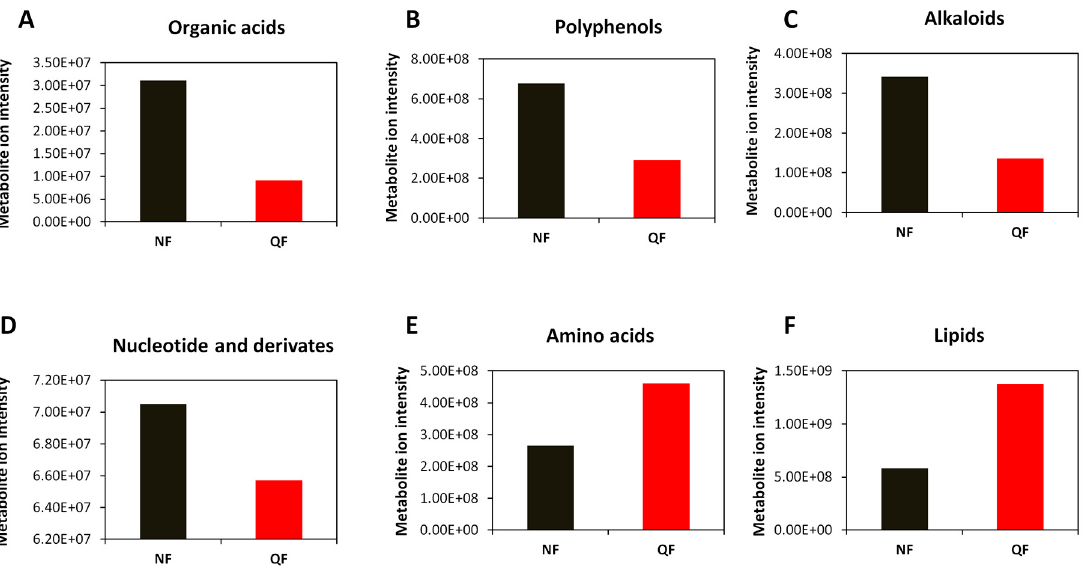
Figure 4. Comparison of the total ion intensity of various classes of metabolites between fruits from Ningxia (NF) and Qinghai (QF). ( A ) Organic acids, ( B ) polyphenols, ( C ) alkaloids, ( D ) nucleotides and derivatives, ( E ) amino acids and ( F ) lipids. Bars represent the sum of ion intensity of all metabolites belonging to each class.